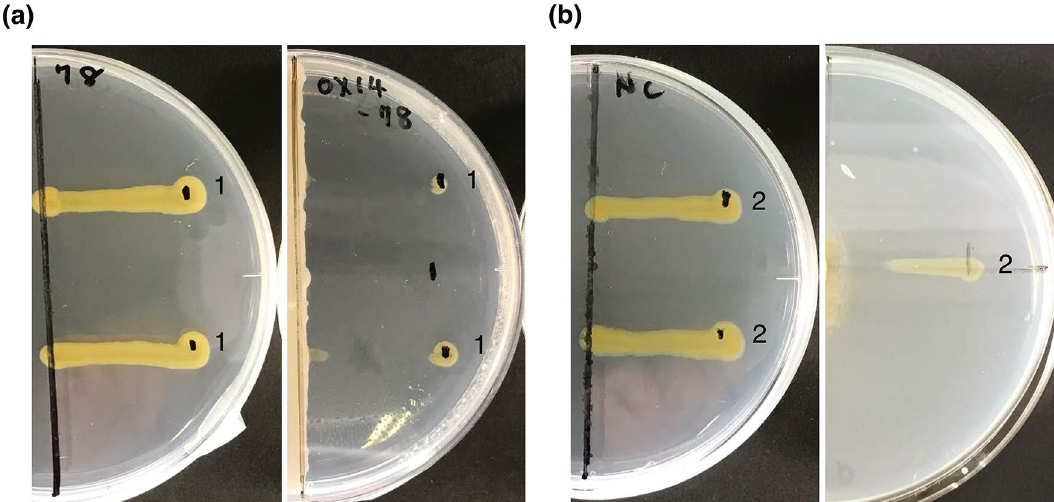
Figure 2. Cross-streaking method. The vertical line ( a ) and circle ( b ) in the right image is ( a ) strain OX14 and ( b ) GL7, and the lines marked with numerical digits are 1: F. psychrophilum KU190628-78 and 2: F. psychrophilum NCIMB 1947T. Left images are positive controls without antagonistic